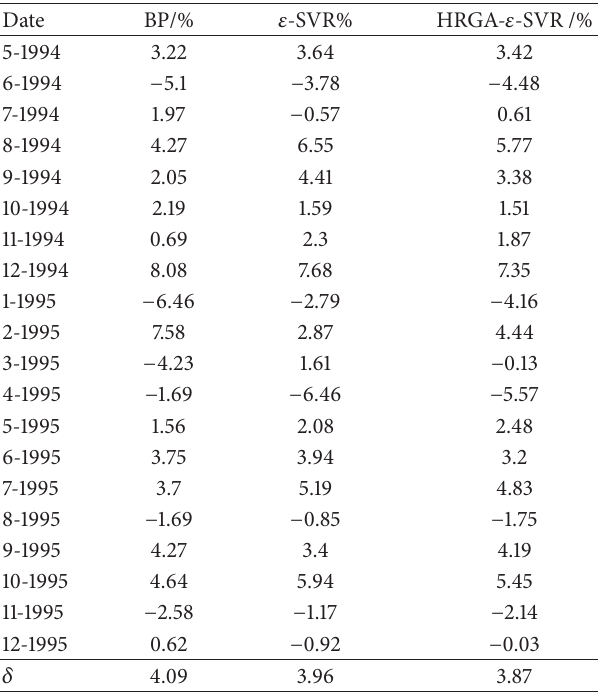
Table 3: Analysis results of forecasting